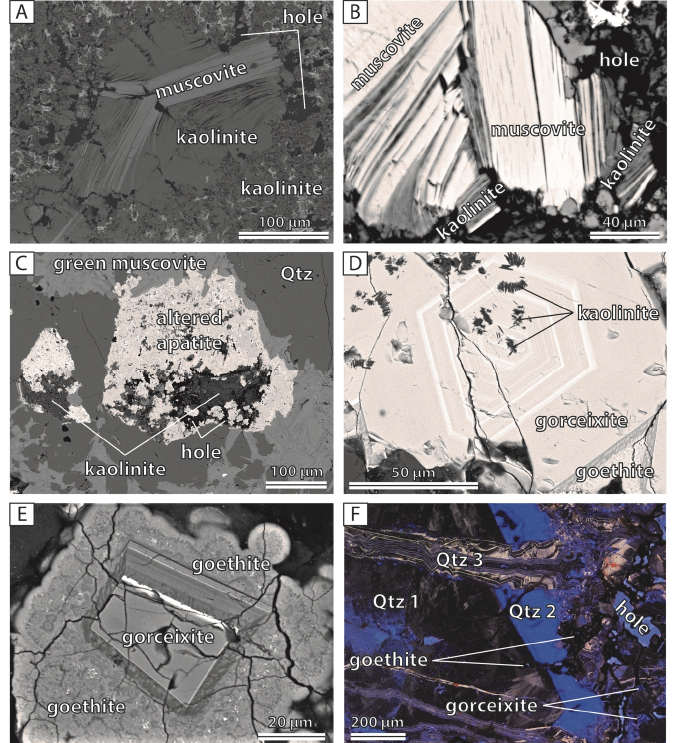
Figure 3. Photomicrographs illustrating the kaolinization assemblage in the Beauvoir granite ( A to C ) and in late quartz veins within ( D to F ). ( A ), ( B ): BSE images showing partial pseudomorphs of kaolinite after greisen muscovite. ( C ): Partial alteration of apatite by kaolinite (BSE). ( D ): Small kaolinite inclusions in a well‐zoned gorceixite crystal. ( E ): A gorceixite crystal overgrown by botryoidal goethite (BSE). ( F ): A cathodoluminescence (CL) image showing three quartz generation plus minor goethite, gorceixite and quartz, in a breccia zone.